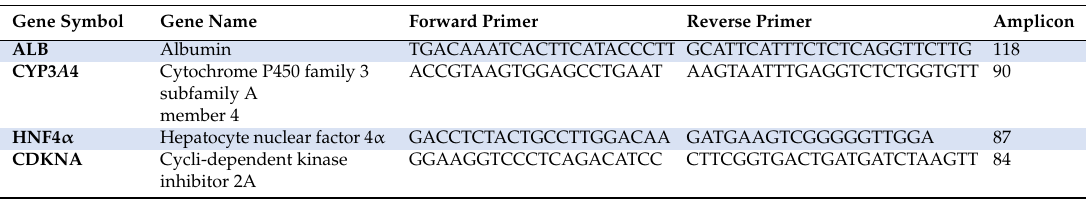
Table 1. Primer sequences for the custom real-time PCR (Primerdesign Ltd., Southampton, UK).